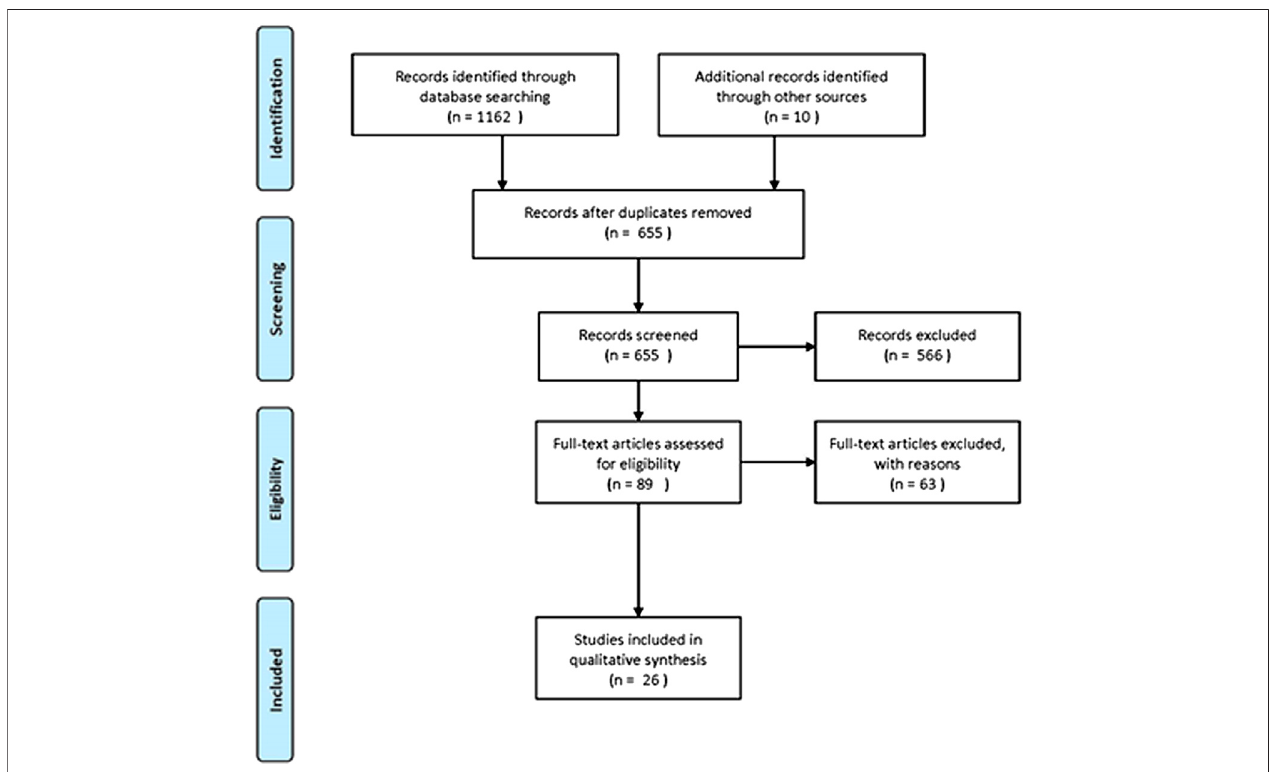
FIGURE 1 | PRISMA fl ow diagram for the ethnobotanical and ethnopharmacological data.